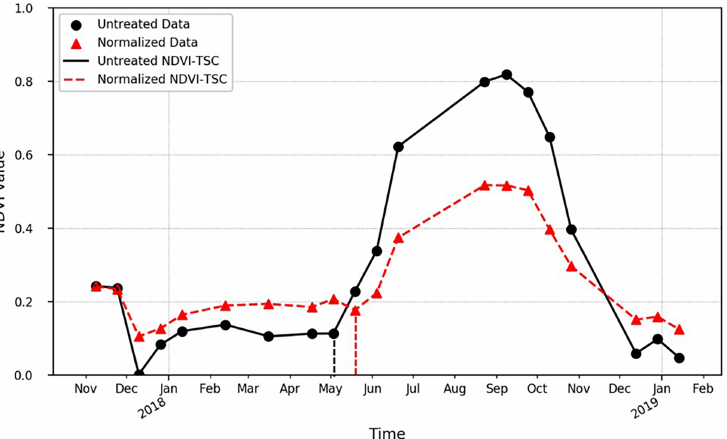
Figure 10. The Comparison of time-series’curve of NDVI values (NDVI-TSC) calculated from pixels in corpland images before (marked in black line) and after (marked in red line) the radiometric